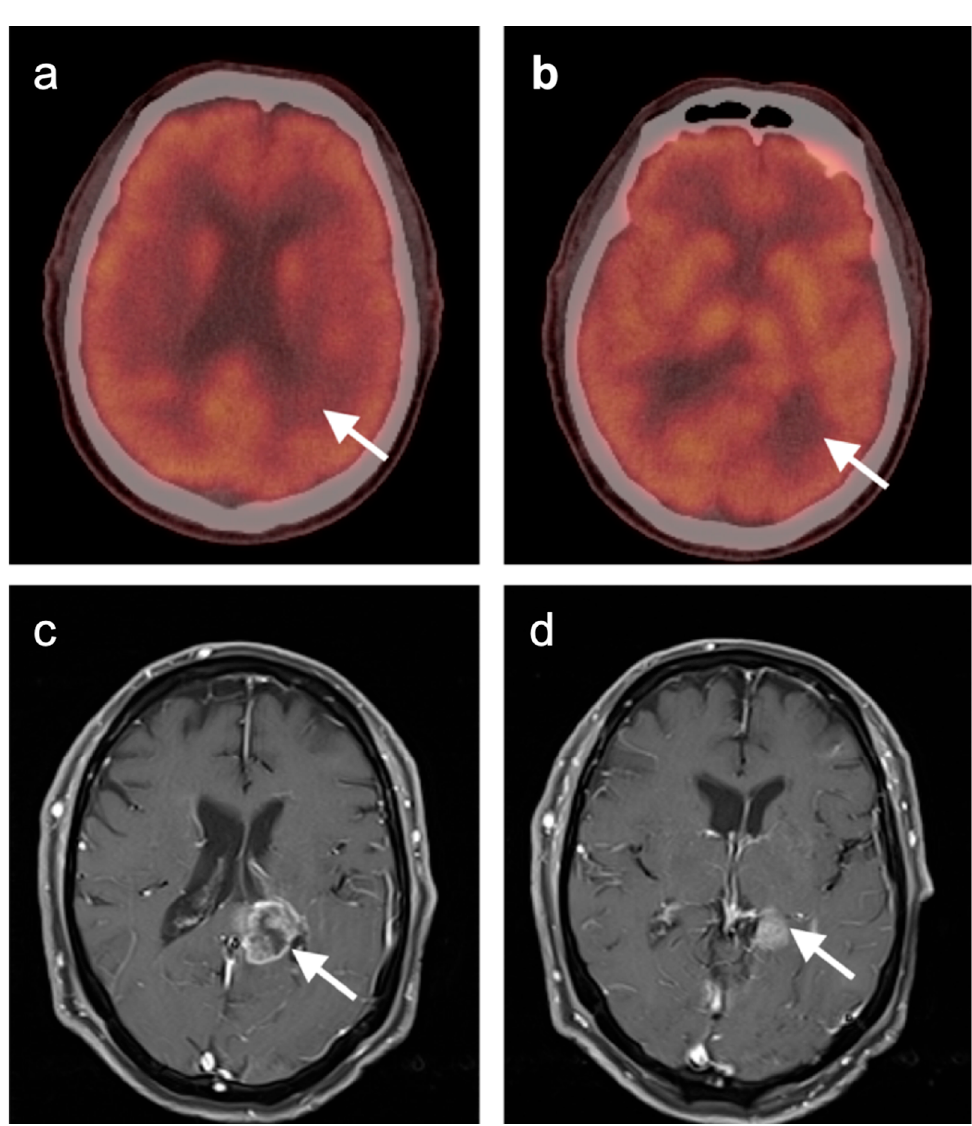
Figure 40. High-grade glioma with low FDG uptake. ( a , b ) FDG PET-CT scan shows very low uptake in the enhancing mass, which was a high-grade glioma by biopsy. ( c , d ) Gd-enhanced T1 fat saturation axial MRI shows an enhancing mass adjacent to the posterior horn of the left lateral ventricle (white arrows). The patient was on high-dose steroids, although it was not clear whether this was the cause of the low metabolic activity in the tumor.